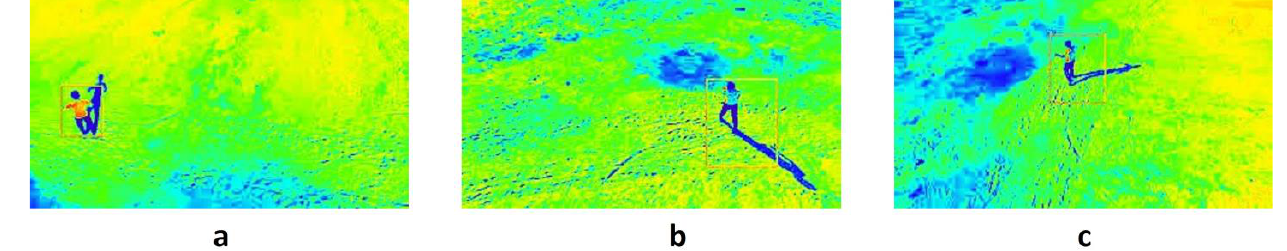
Figure 9. Vertical view using thermal camera to detect person at different altitudes: ( a ) 5 m, ( b ) 10 m, ( c ) 15 m.